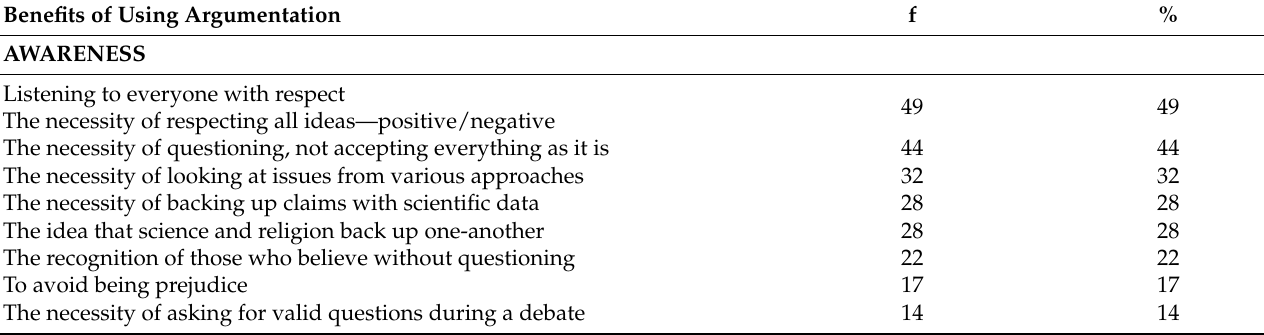
Table 1. Themes and codes under “Benefits of Using Argumentation”